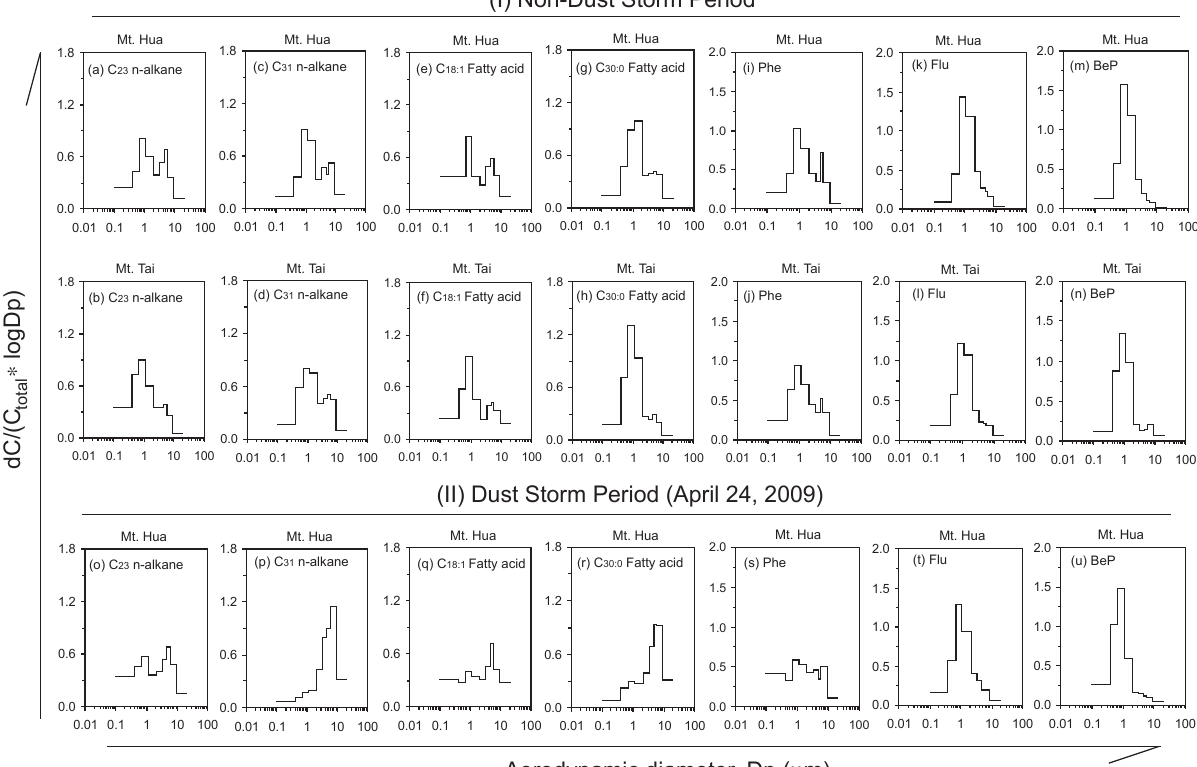
Fig. 9. Differences in size distributions of water-insoluble organic aerosols at Mt. Hua and Mt. Tai during (I) the nonevent and (II) the event Figure 9. Differences in size distribution of water-insoluble organic aerosols collected at Mt. Hua and Mt. Tai during (I) the non-dust storm and (II) the dust storm periods